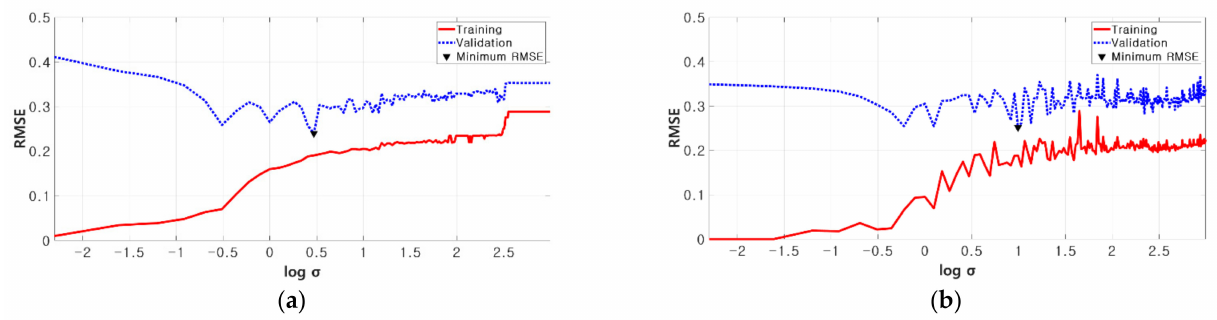
Figure 2. Process of optimizing the parameter for RVM ( a ) and SVM ( b